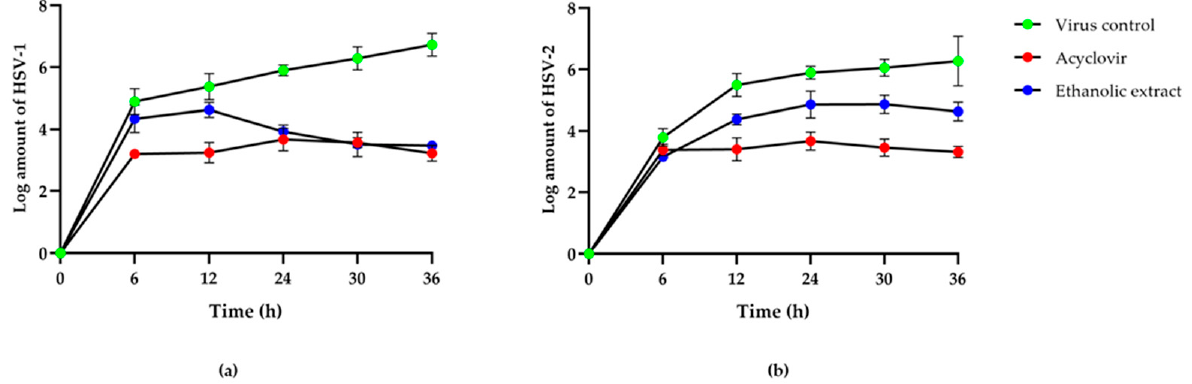
Figure 2. Log titers of HSV-1 ( a ) and HSV-2 ( b ) at 0, 6, 12, 24, 30, and 36 h after treatment with ethanolic extract of red jasmine rice at 625 µg/mL, compared with antiviral agent, acyclovir and virus control.